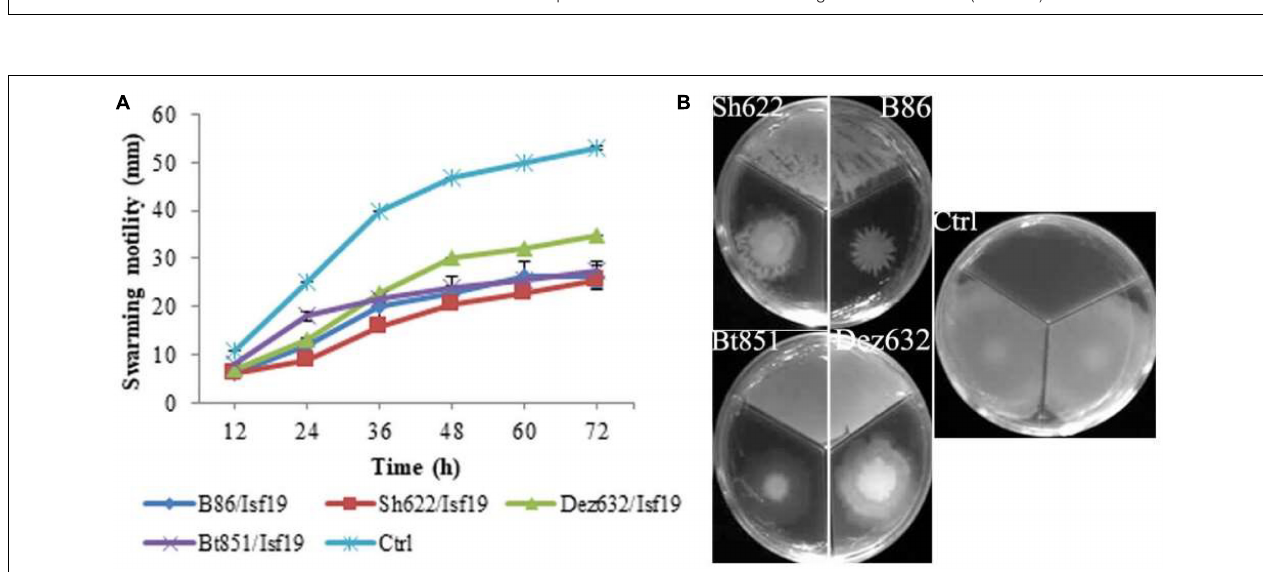
FIGURE 1 | Effects of VOCs produced by Streptomyces sp. B86 , Pantoea sp. Dez632 , Pseudomonas sp. Bt851, and Stenotrophomonas sp. Sh622 on (A) soft rot development by B. pumilus Isf19 in sugar beetroot slices compared to the non-treated control (Ctrl), and (B) cell population of B. pumilus Isf19. Three replicates were used for each treatment. Error bars indicate the SE of the three replicates. Different letters indicate significant differences ( P = 0.05).